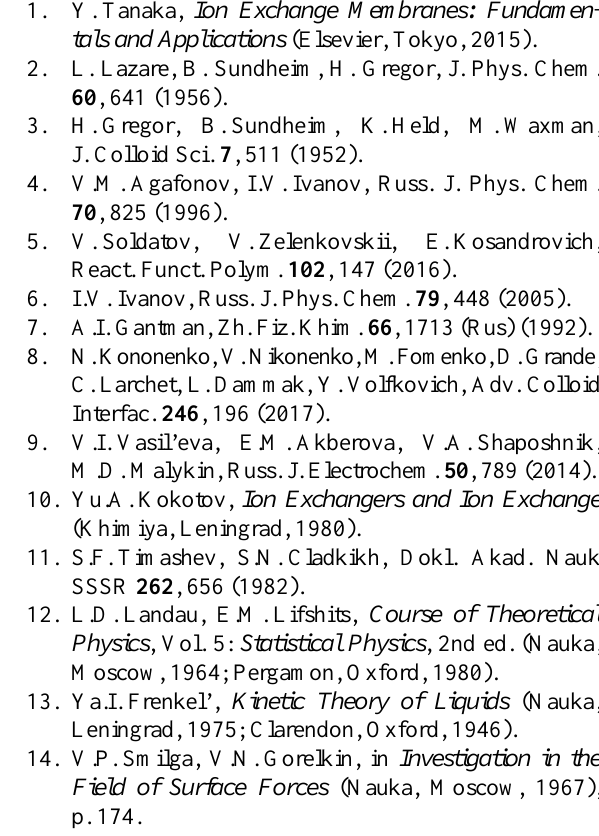
β 0 = 2, C = 10,27 ( 3